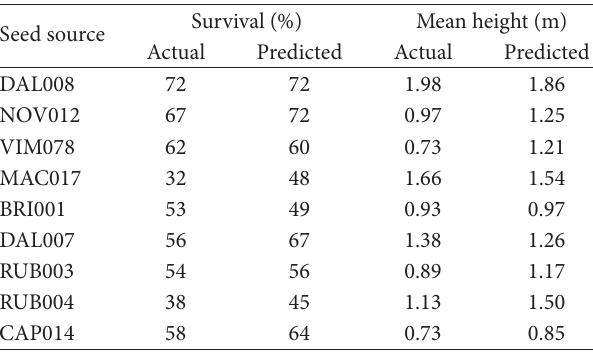
T 4: Comparison of actual versus predicted development—age 12 months.